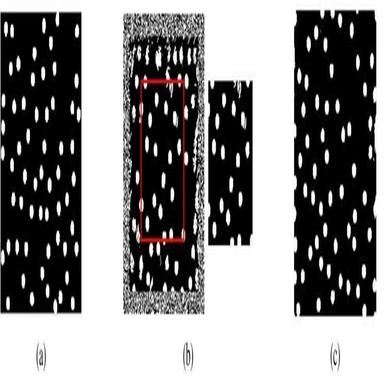
Microstructure reconstruction by using data templates with different radii r.